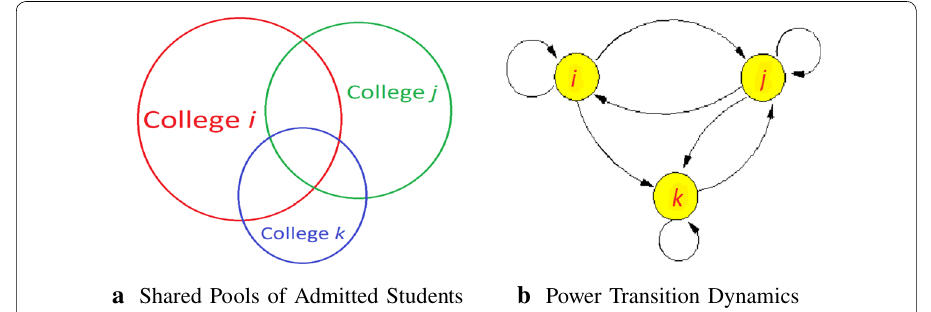
Fig. 1 Interactions among colleges i , j , and